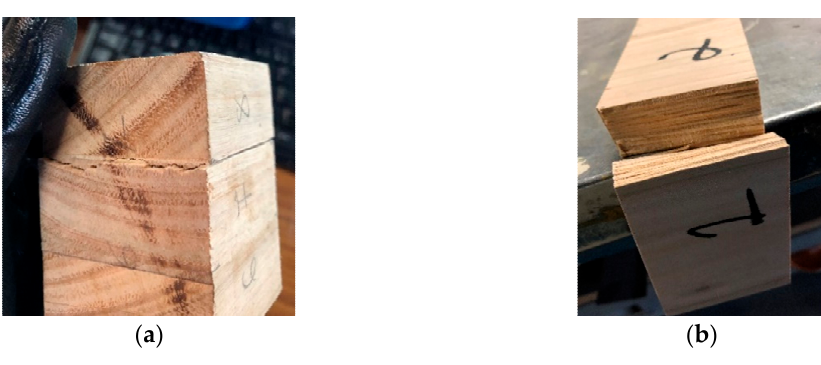
Figure 7. Typical wood shear failure observed during the shear tests performed. ( a ) Surface-bonding specimens (Bi) and ( b ) edge-bonding specimens